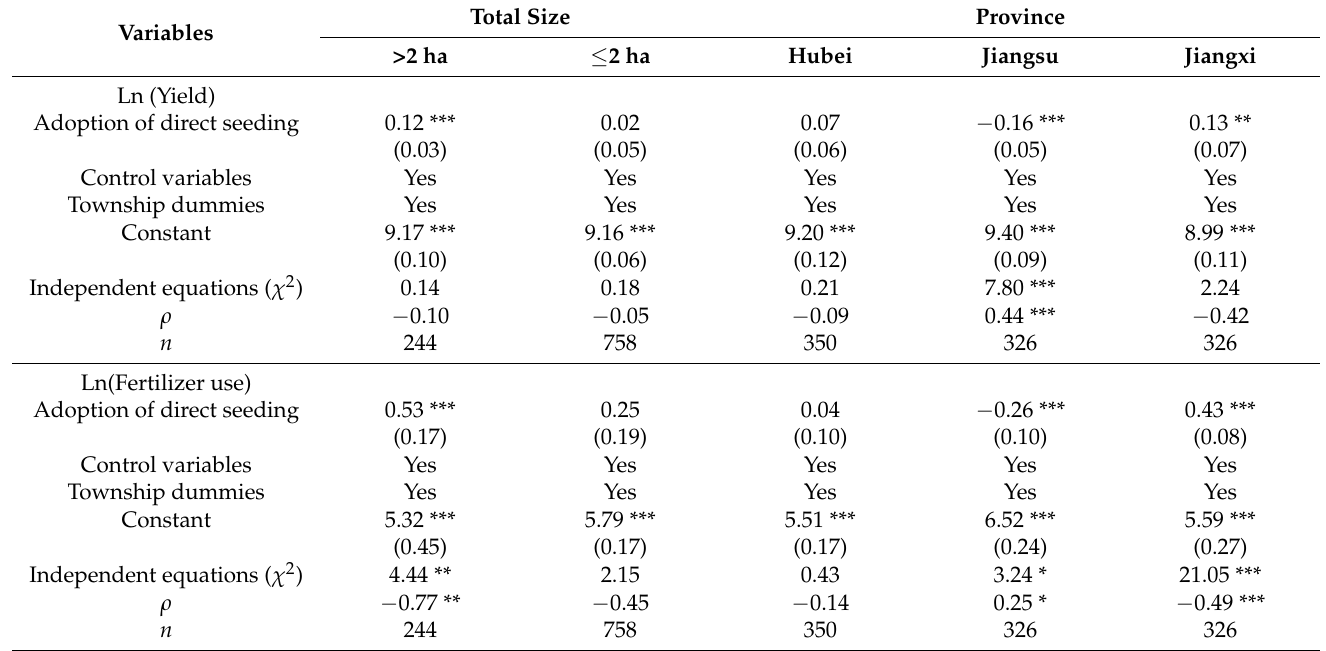
Table 8. Estimated results for the heterogeneity